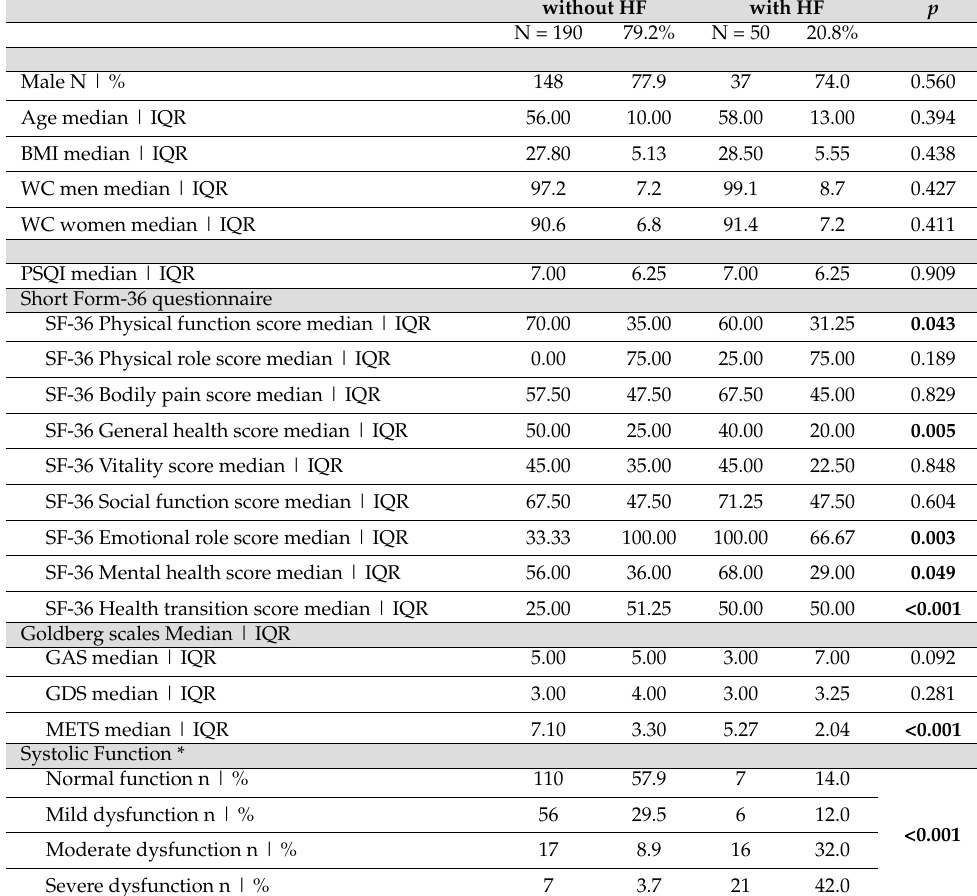
Table 5. Comparison of baseline data based on heart